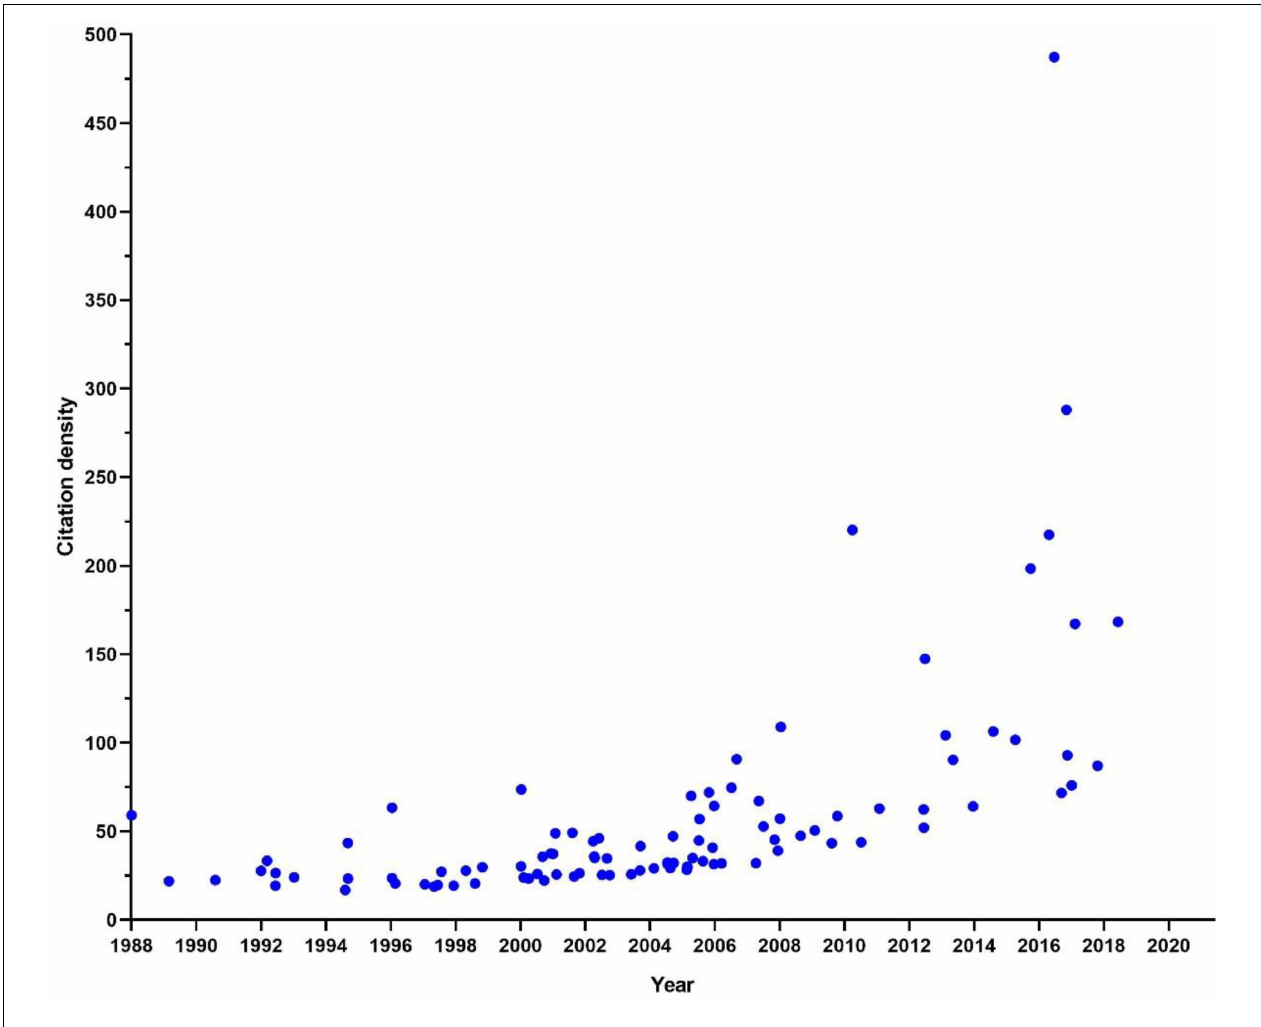
FIGURE 3 | Scatter plot of citation densities of each